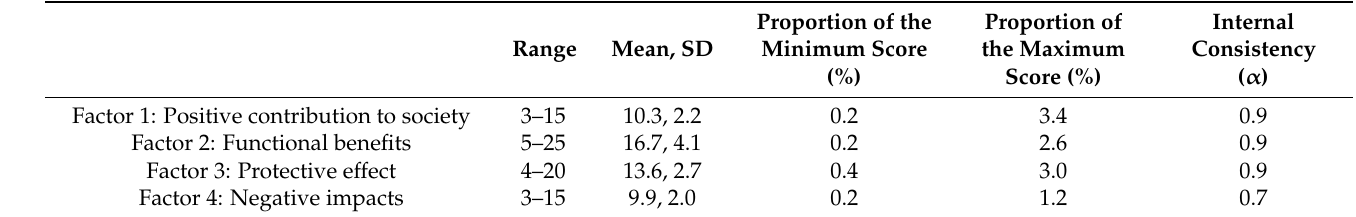
Table 3. Psychometric properties of the factors of the 15-item Outcome Expectancy Scale for COVID- 19 Vaccination ( n =